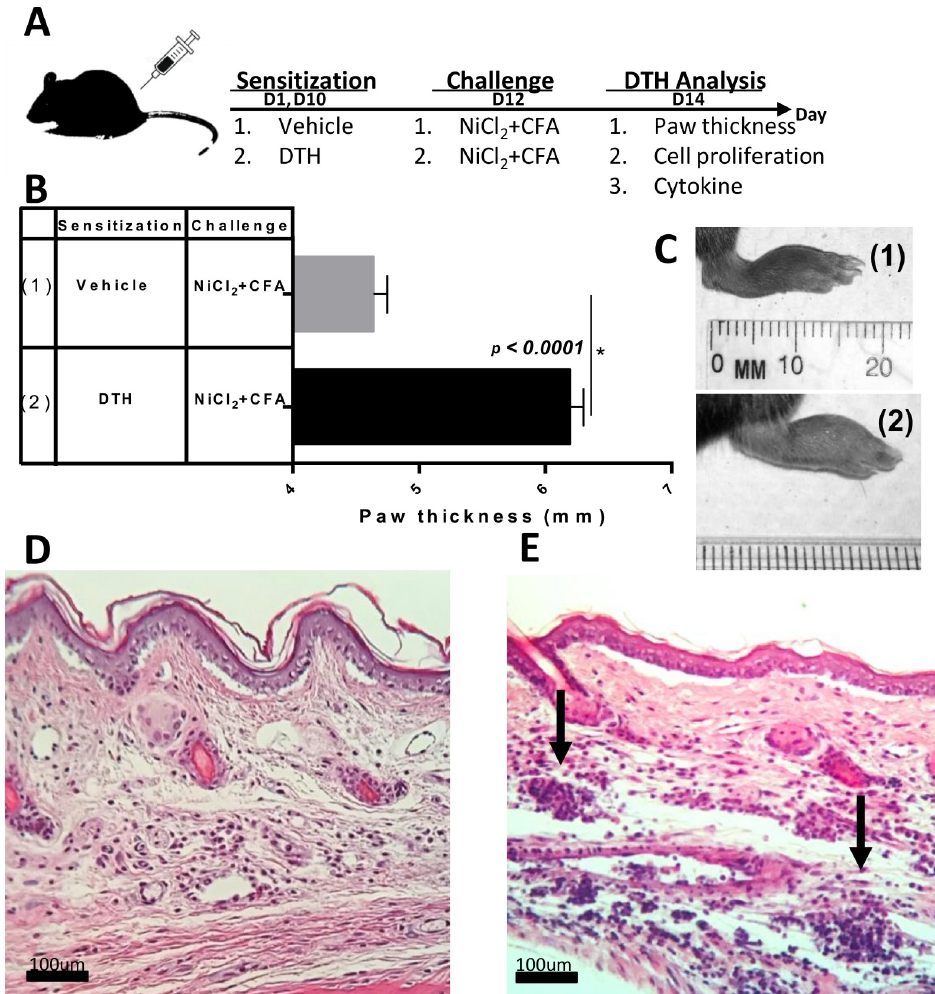
Fig 1. In vivo exposure to orthopedic implant metal(s) induces metal-DTH responses. (A) Schematic model for generating metal-DTH to orthopedic implant metal(s) in vivo. (B) DTH was determined by measuring paw thickness 48 h after challenge (D 14) in C57BL/6 mice that were sensitized and challenged as indicated on D 12 and (C) corresponding representative photographs of inflammatory lesions in the paw of vehicle and metal-DTH mice on D 14. C57BL/6 mice that were paw challenged without prior sensitization, vehicle group (Group 1), served as negative controls. Representative paw histology sections from (D) vehicle-treated or (E) DTH-treated C57BL/6 mice, demonstrating inflammatory lymphocytic infiltrations (arrows) found in the paw tissue of DTH mice. Data represent three independent experiments with four mice/group in each experiment. The amount of cell proliferation is represented as the mean of counts per minute (cpm) ± SEM. Statistical significance was determined by Student’s unpaired two-tailed t-test and asterisk ( � ) denote significant differences P � 0.05. metal-DTH Caspase-1-/- mice had less paw inflammation (mean paw thickness = 3.77 mm) compared with metal-DTH Nlrp3-/- mice (mean paw thickness = 4.54 mm; Fig 3A vs. 4A). Caspase1-/- metal-DTH mice also displayed significant decreases in both splenic and CD4 + T cell proliferation to metal challenge ( Fig 4C and 4D ). These results reveal that metal- DTH responses to implant debris are dependent on active NLRP3 inflammasome and cas- pase-1 signaling in vivo and in vitro. However, this data also reveals that immune reactivity during a metal-DTH response, are more dependent on active caspase-1 signaling than the NLRP3 inflammasome.